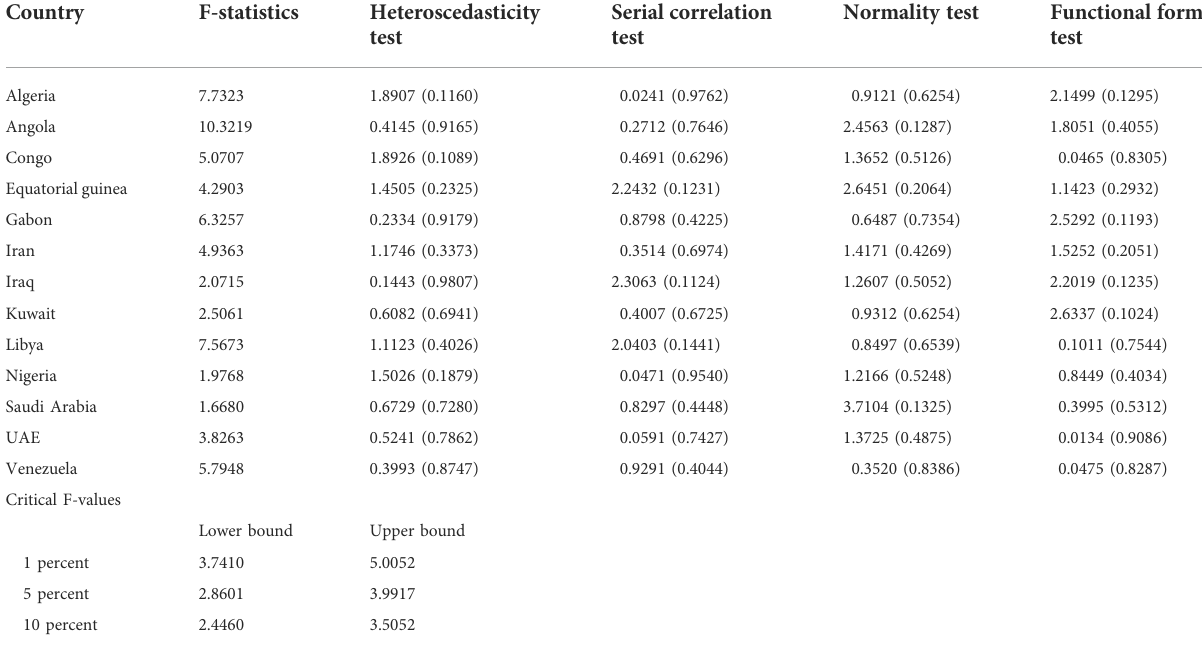
TABLE 2 Cointegration